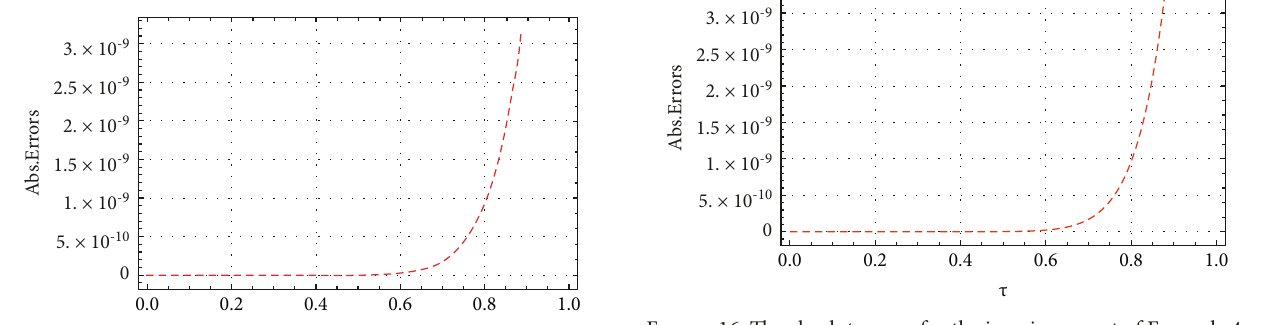
Figure 16: The absolute error for the imaginary part of Example